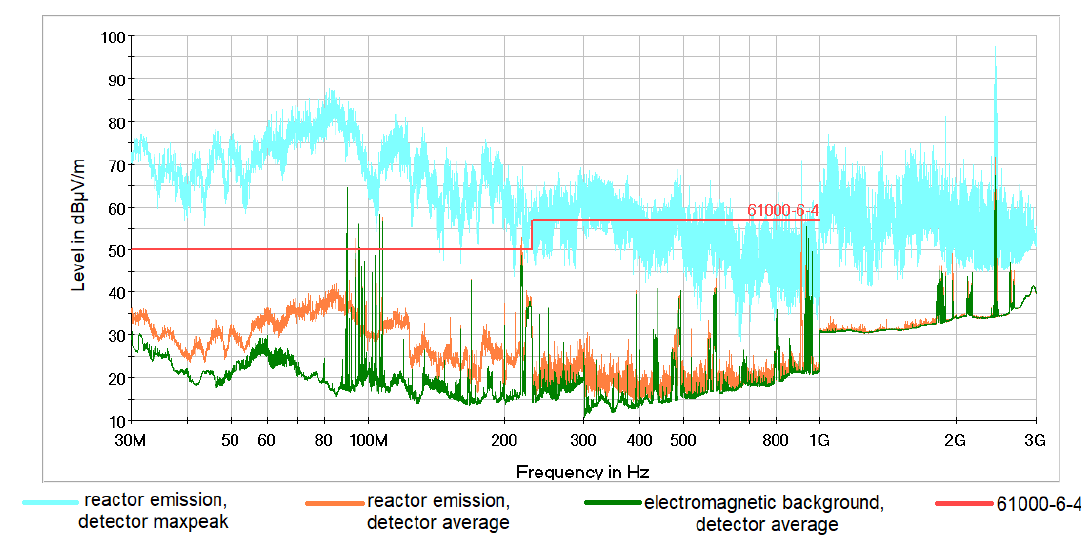
Figure 6. Measurement results — radiated emission, vertical polarisation.